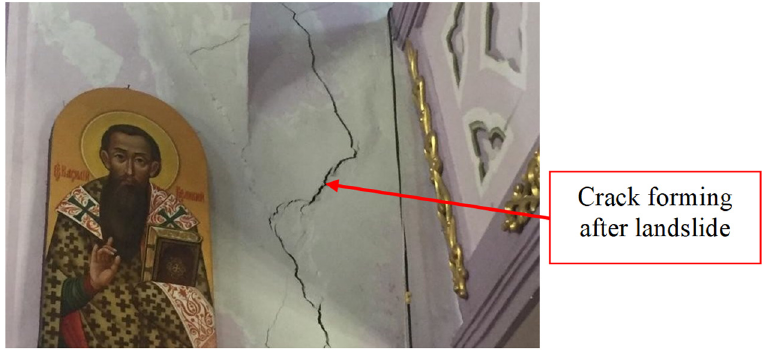
Figure 2. Deformations of the St. Illia Church.